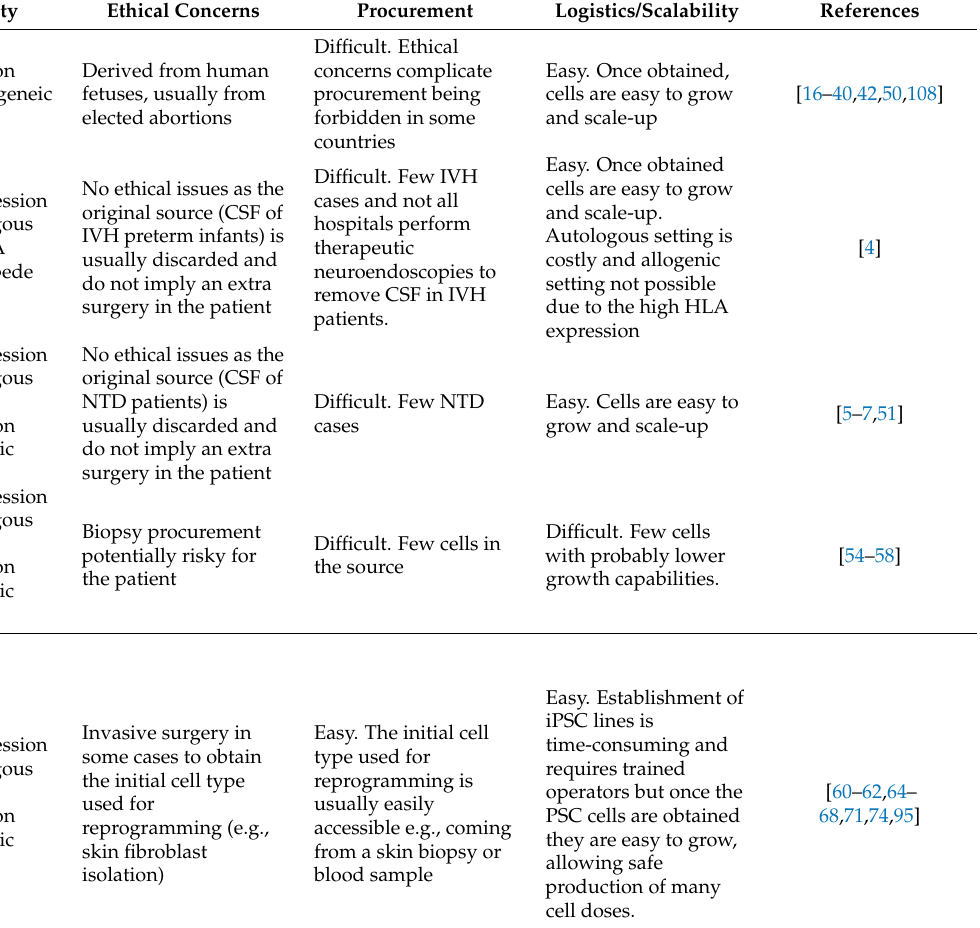
Table 2. Safety, efficacy, scalability, and quality control considerations for clinical application of NSC from different